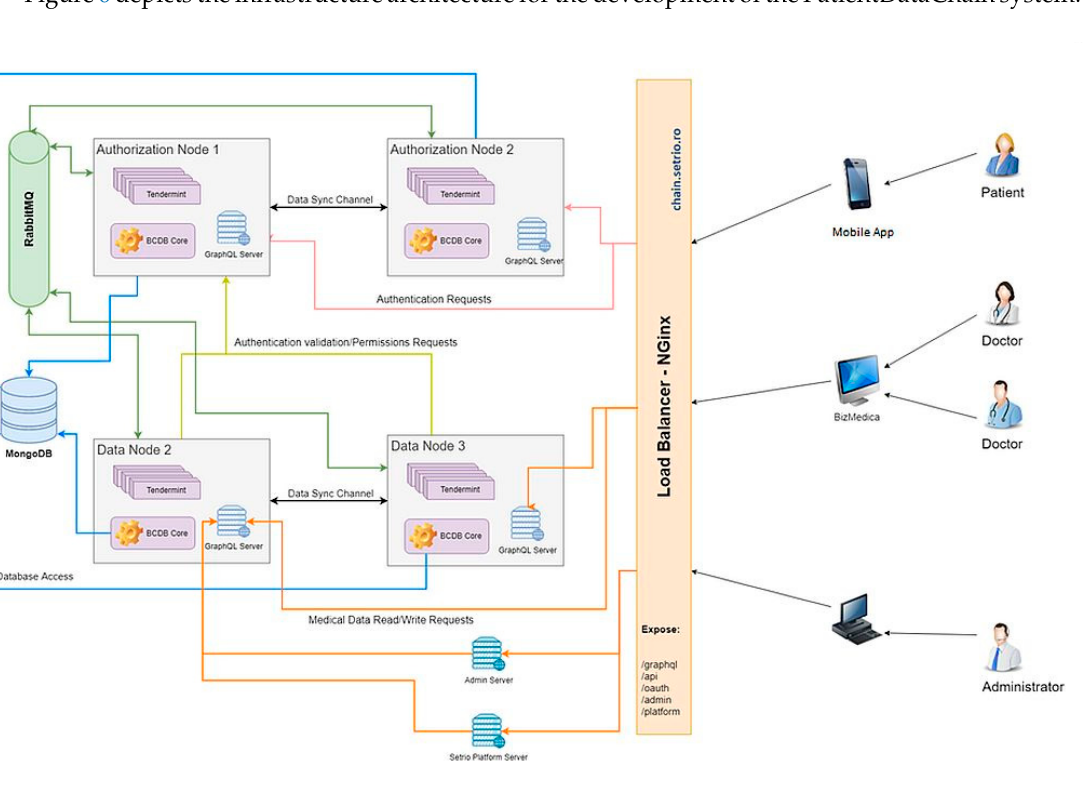
Figure 6. PatientDataChain infrastructure architecture .